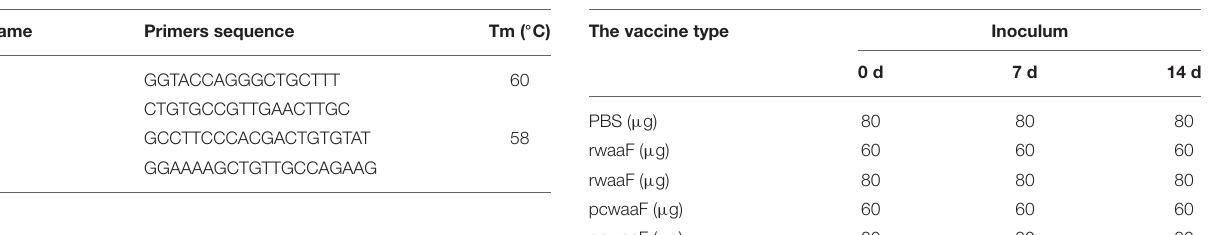
TABLE 1 | Primers for qRT-PCR. TABLE 2 | Vaccine safety assessment